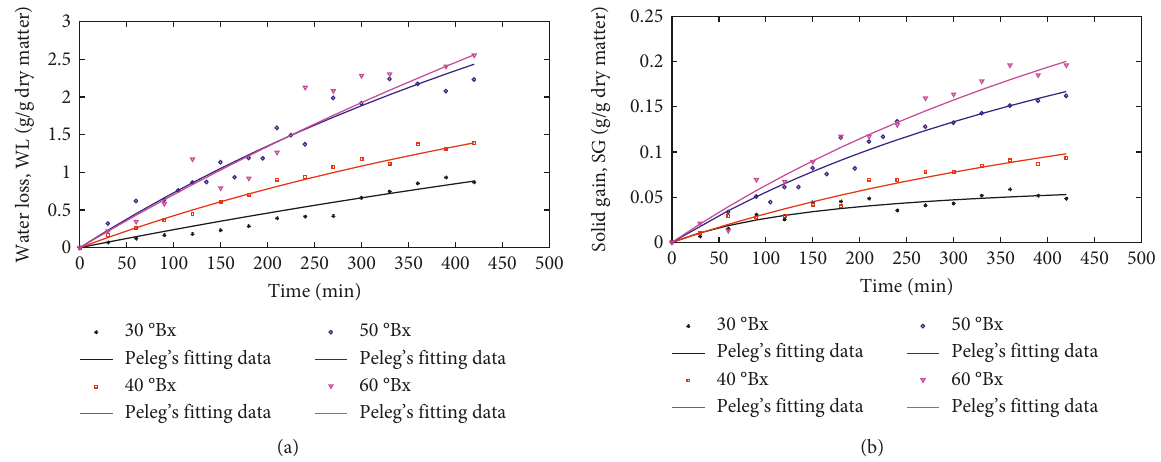
Figure 2: Effect of osmotic solution solid content on the mass transfer during OD of pomegranate seeds: (a) water loss and (b) solid gain ( T 330rpm, and sample/solution weight ratio 30 ° C, N (cid:31) (cid:31)